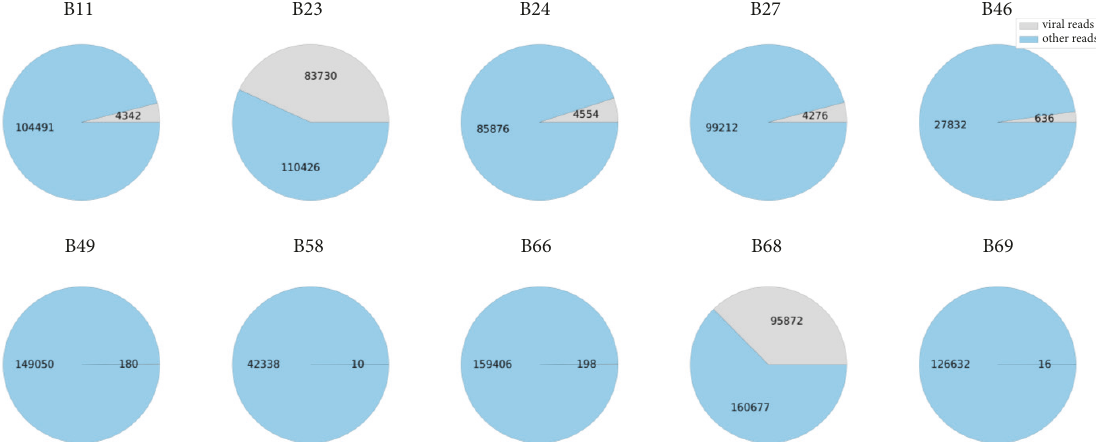
Figure 4: A graphical representation of the percentage of the detected viral reads (grey) with respect to the total number of sequencing reads obtained for the samples listed in Table